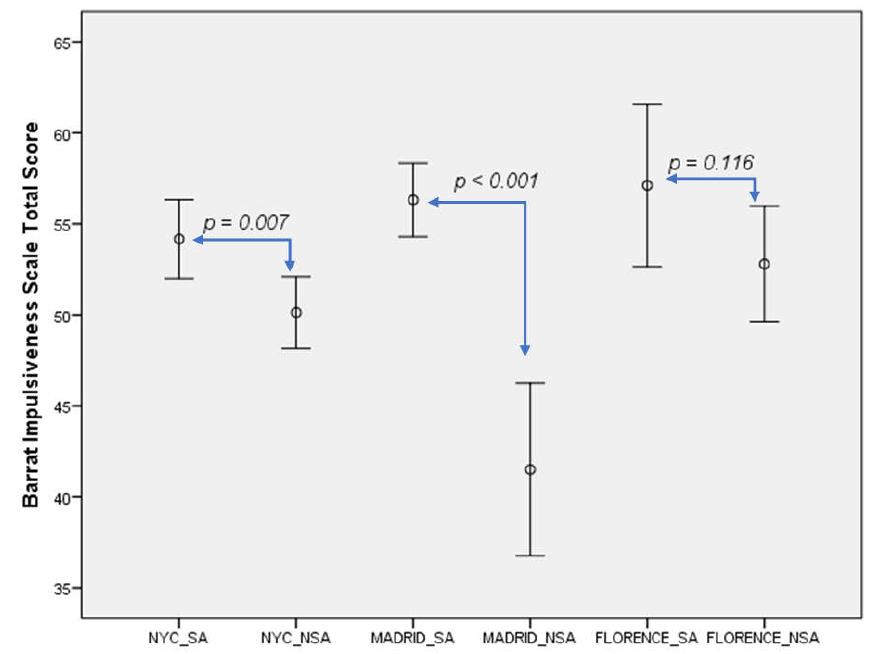
Figure 2 . Impulsivity levels differences between suicide attempters and non-attempters across sites. NYC: New York City. SA: Suicide attempters. NSA: non-suicide attempter.